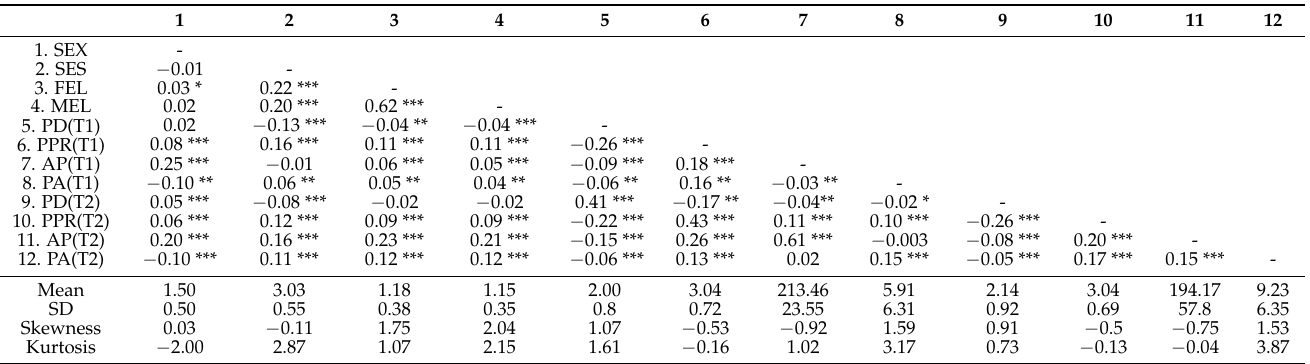
Table 1. Descriptive statistics and correlation analysis.